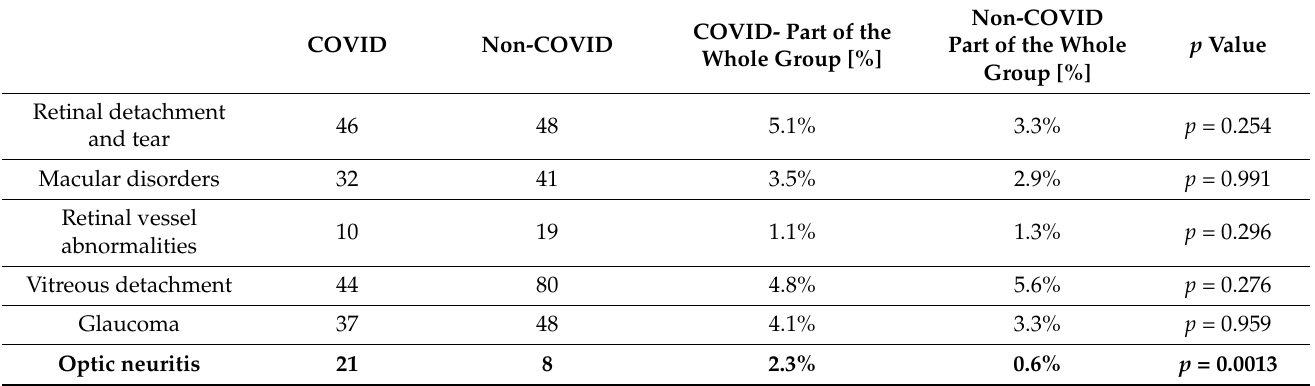
Table 4. Posterior segment diseases in COVID lockdowns (16th of March-15th of April 2020, 16th of March–15th of April 2021, November 2020, 90 days) and non-COVID times (16th of March–15th of April, November 2019, 60 days), total prevalence and percentage of all diagnoses. Non-COVID COVID- Part of the COVID Non-COVID Part of the Whole Whole Group [%] Group [%]